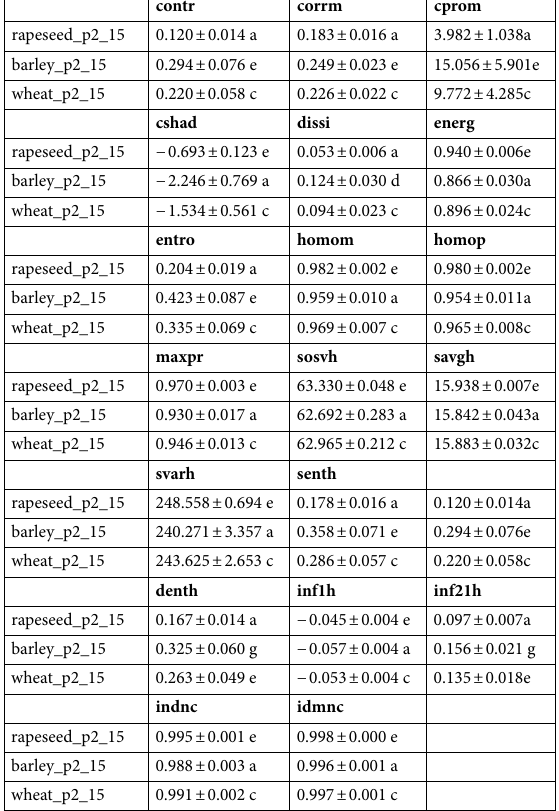
Table 6. Texture analysis of kernels for selected air stream velocities (15 m s −1 ) and the position of the seed-air tube of type II. a–e: the differences between mean values with the same letter in columns were statistically insignificant ( p <